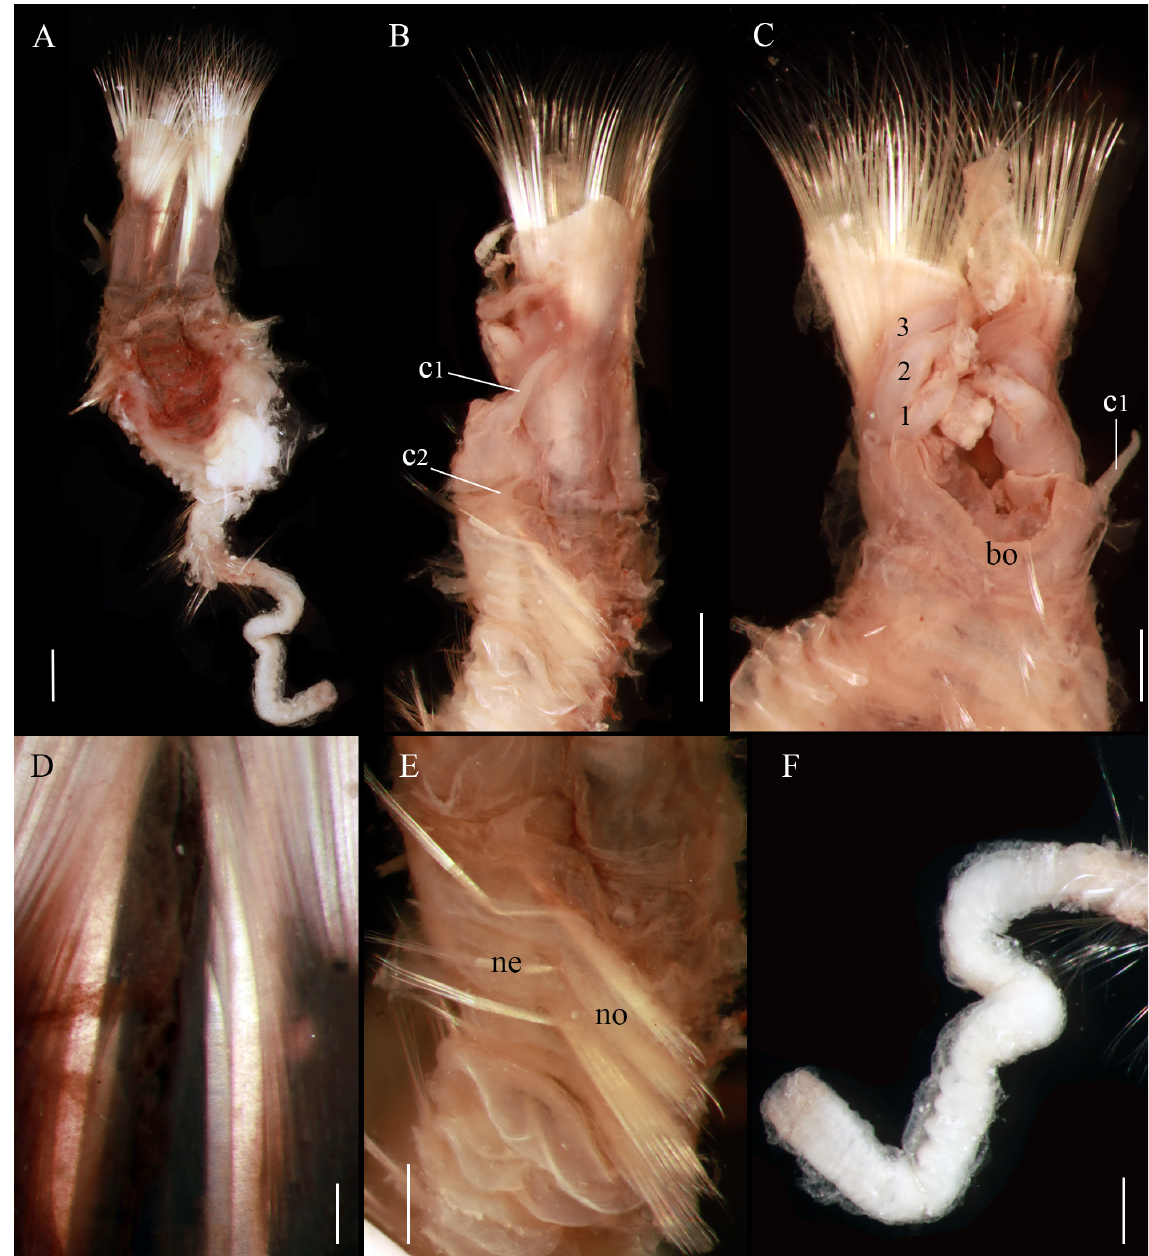
Fig. 3. Mariansabellaria caribbea sp. nov., holotype (ECOSUR-303). A . Complete specimen, dorsal view. B . Anterior region left lateral view. C . Anterior region ventral view. D . Nuchal spines. E . Parathorax left lateral view. F . Caudal peduncle. Abbreviations: bo = building organ; c1 = cirrus 1 st thoracic; c2 = cirri 2 nd thoracic segment; ne = parathoracic neuropodium; no = parathoracic notopodium. Numbers indicate the tentacular filaments. Scale bars: A–B, E: 1 mm; C, F: 0.5 mm; D: 200